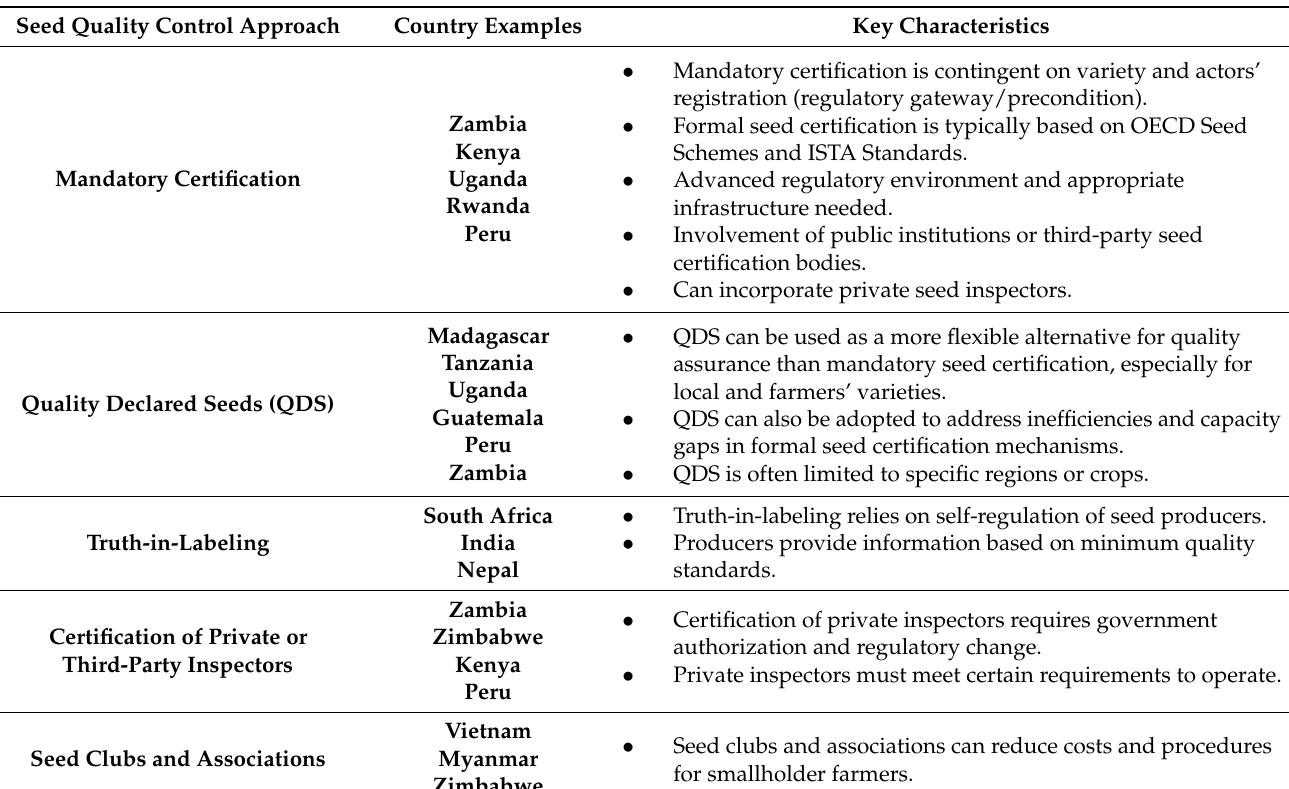
Table 2. Key characteristics of seed quality control